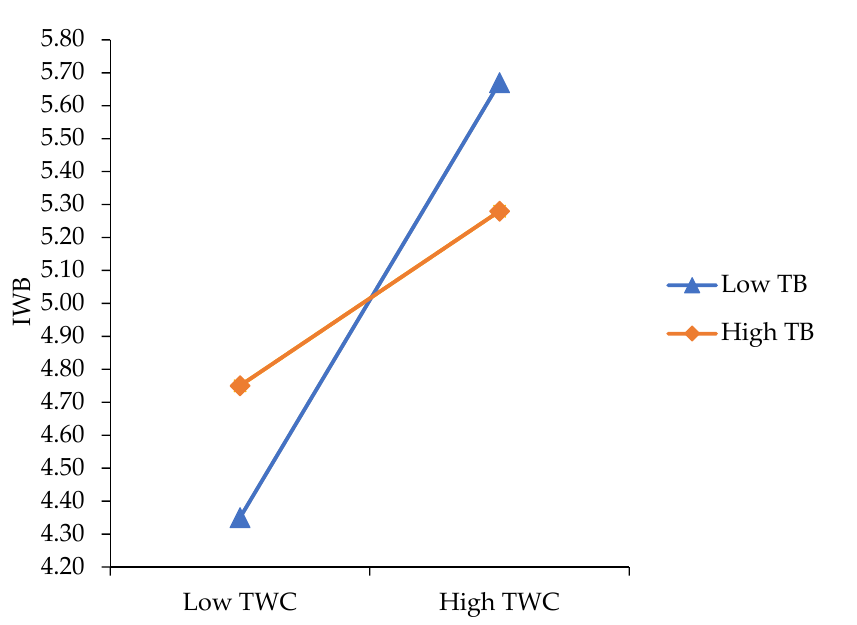
Figure 3. Relationship between TWC and IWB at low and high levels of TB.